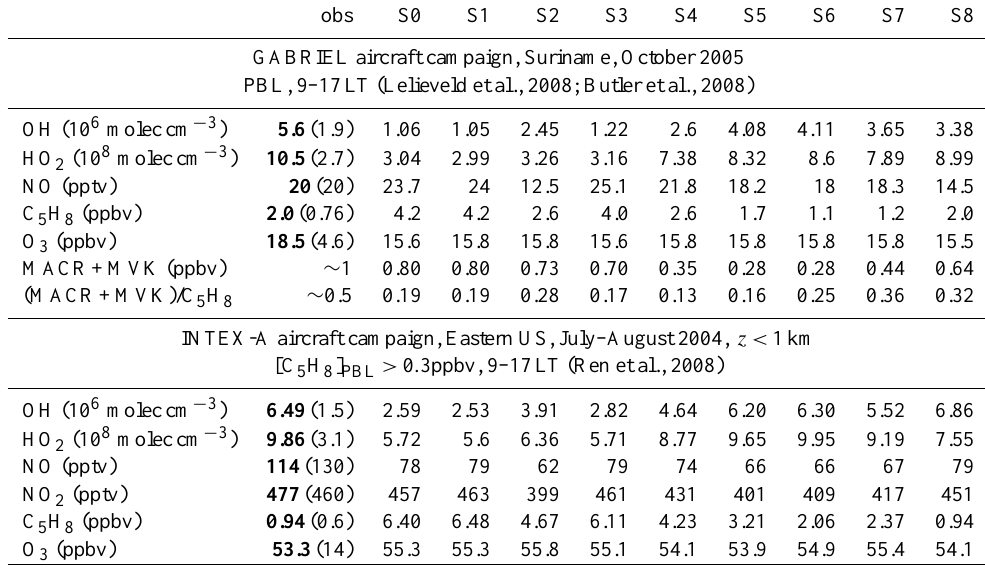
Table 4. Concentration of key compounds measured during the GABRIEL and INTEX-A campaigns and comparisons with the model simulations. The mean concentrations during daytime are used for the comparisons. The standard deviations are in